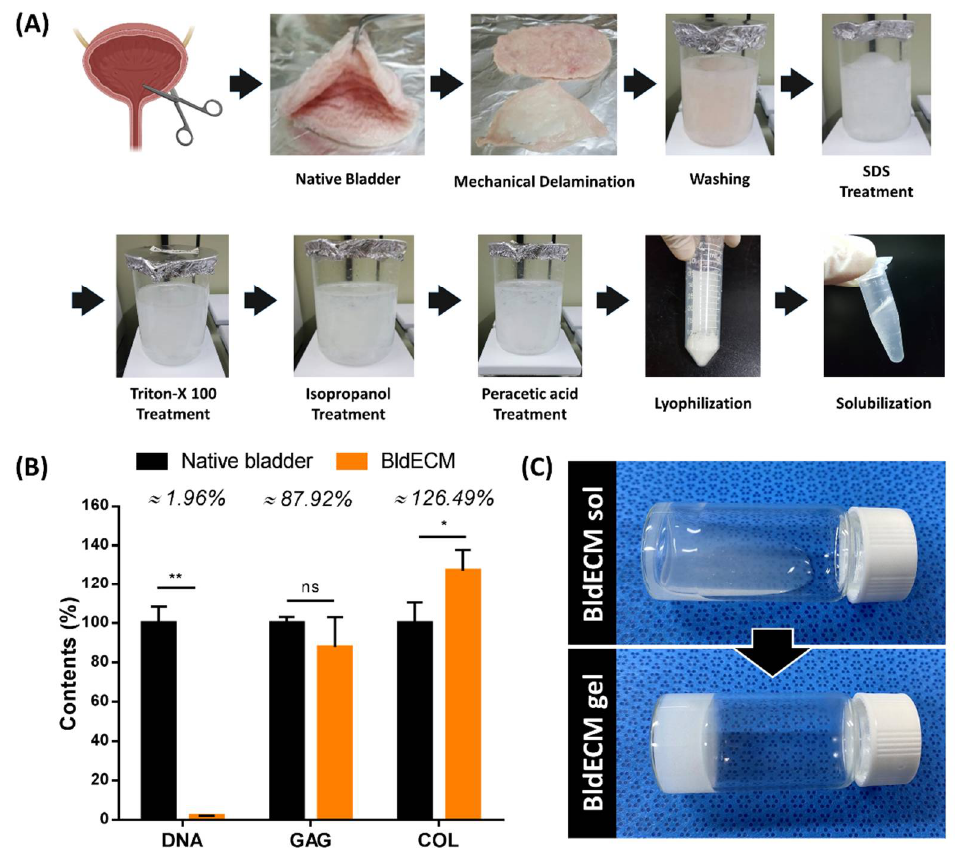
Figure 2. Preparation of the decellularized extracellular matrix from the bladder tissue. ( A ) Decellularization process through a series of physical, chemical, and enzymatic treatments. ( B ) Biochemical assays to evaluate decellularization, such as residual DNA, GAGs, and collagen contents in the BldECM and native bladder tissues (* p < 0.05 and ** p < 0.01; ns: Not significant). ( C ) Sol to gel transition of pH-adjusted BldECM hydrogel after incubation at 37 °C for 30 min.